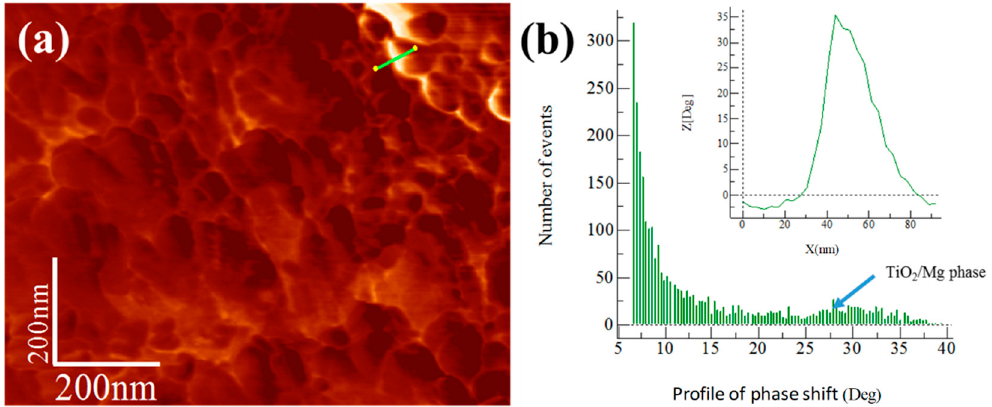
Figure 8. Alp-TiO 2 master compound: ( a ) AFM tapping mode image and ( b ) degree distribution profile of phase shift and distribution profile of corresponding continuous line that crosses the bright area in the phase image (shown inset of the figure).